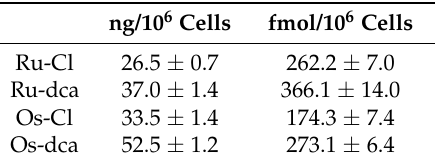
Table 1. Cellular accumulation of complexes Ru-Cl , Ru-dca , Os-Cl and Os-dca (calculated as the metal content) at the A2780 cells after the treatment for 24 h by the equipotent (IC 50 ) concentrations. The data are given as arithmetic means from three independent